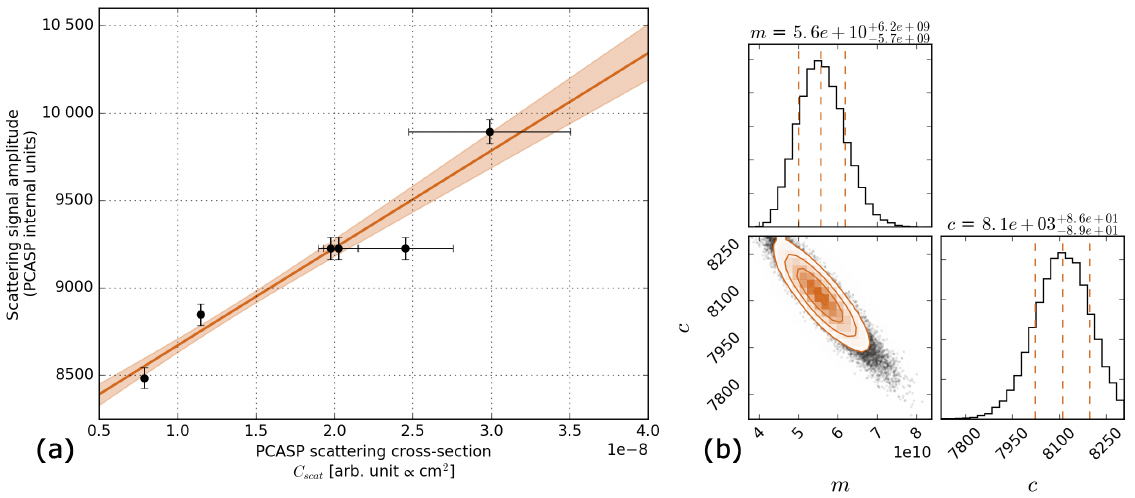
Figure A2. PCASP (low gain stage) calibration results for the approach of Rosenberg et al. (2012). The black markers in panel (a) represent the centers of the scattering signal amplitude histogram modes measured for the PSL standards and the corresponding calculated mean scat- tering cross sections. The error bars represent the histogram modes’ half widths and scattering cross-section standard deviations respectively. The red brown solid line shows the best fit and the shaded area the range between the 16 and 84th percentiles of the fit function PDFs. To allow for direct comparison with the results of the new method, panel (b) shows the parameter solution ensemble in the same way as in Fig.